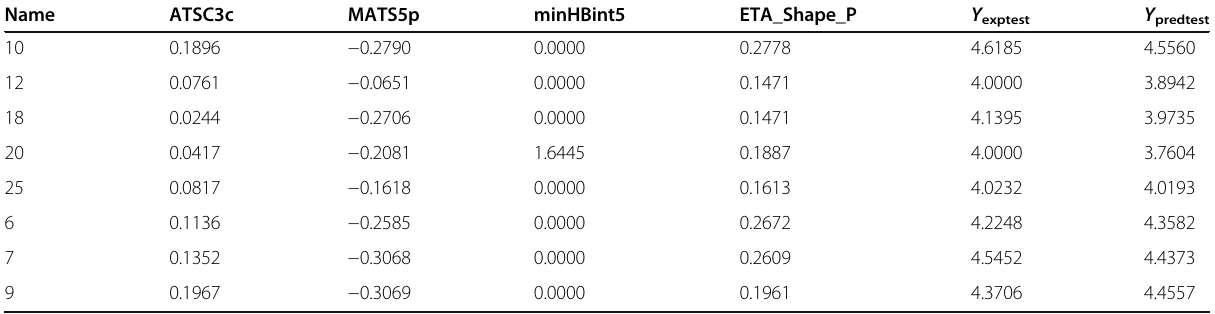
Table 5 External validation of developed